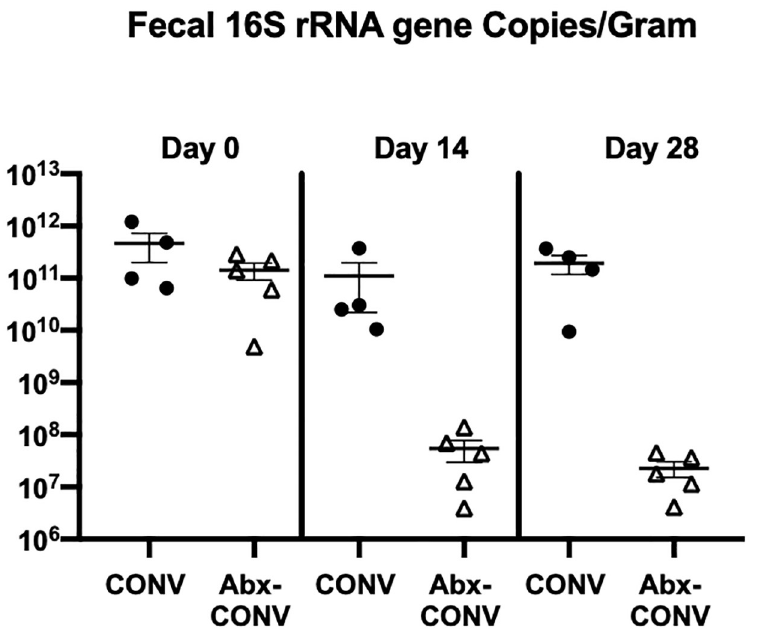
Fig 2. Microbiome analysis. Treatment with antibiotics resulted in a decrease in absolute quantification of 16S rRNA copies/gram at both day 14 and day 28 (n = 4 CONV mice, n = 5 Abx-CONV mice).